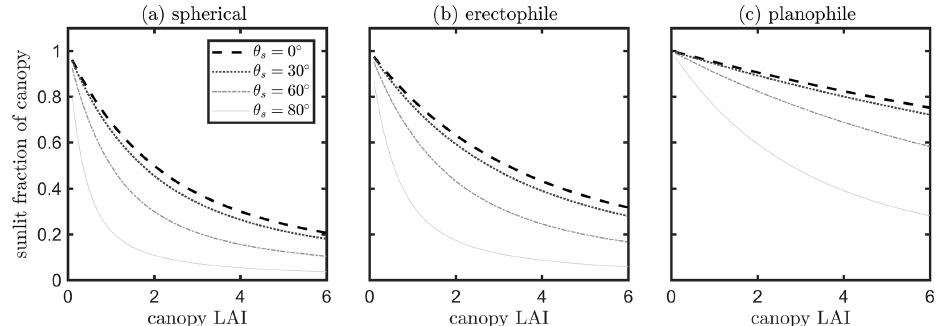
Figure 13. Fraction of sunlit canopy changing with canopy LAI and solar zenith angle ( θ s ) for a canopy with spherical (a) , erectophile (b) and planophile (c) leaves.